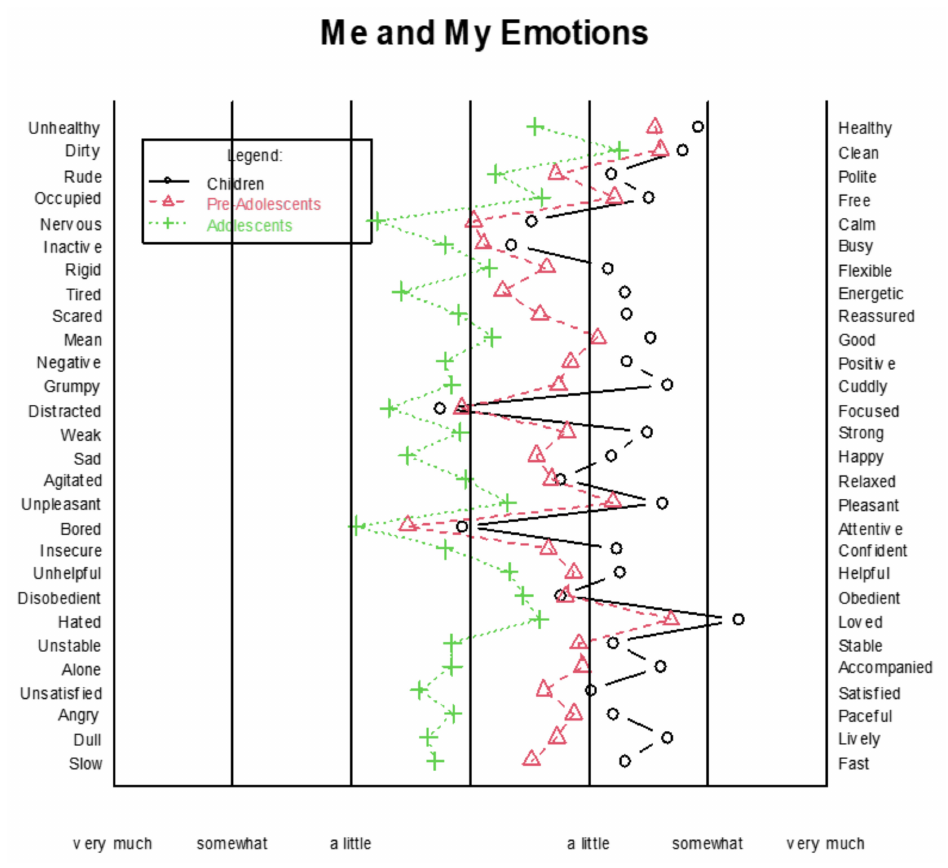
Figure 3. The trend of emotions reported by children ( n = 265), pre-adolescents ( n = 293), and adolescents ( n = 489) during the quarantine